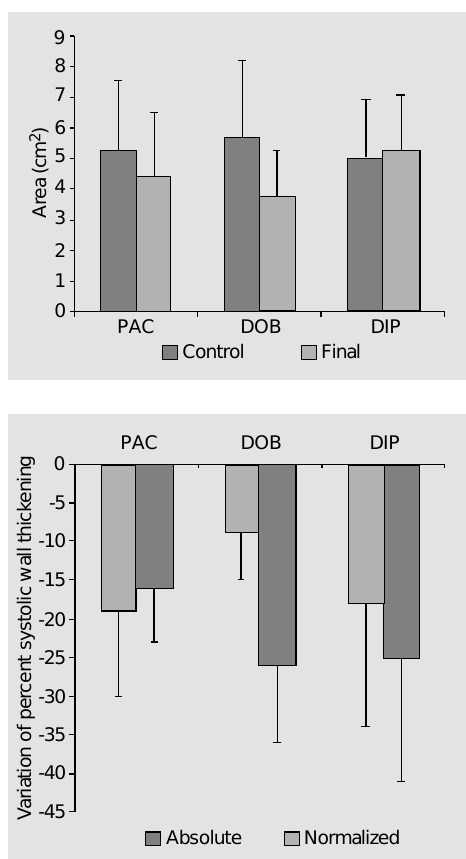
Figure 2. End-diastolic left ven- tricular area at baseline and at the end of each stress test. PAC, atrial pacing; DOB, dobutamine infusion; DIP, dipyridamole infu- sion.